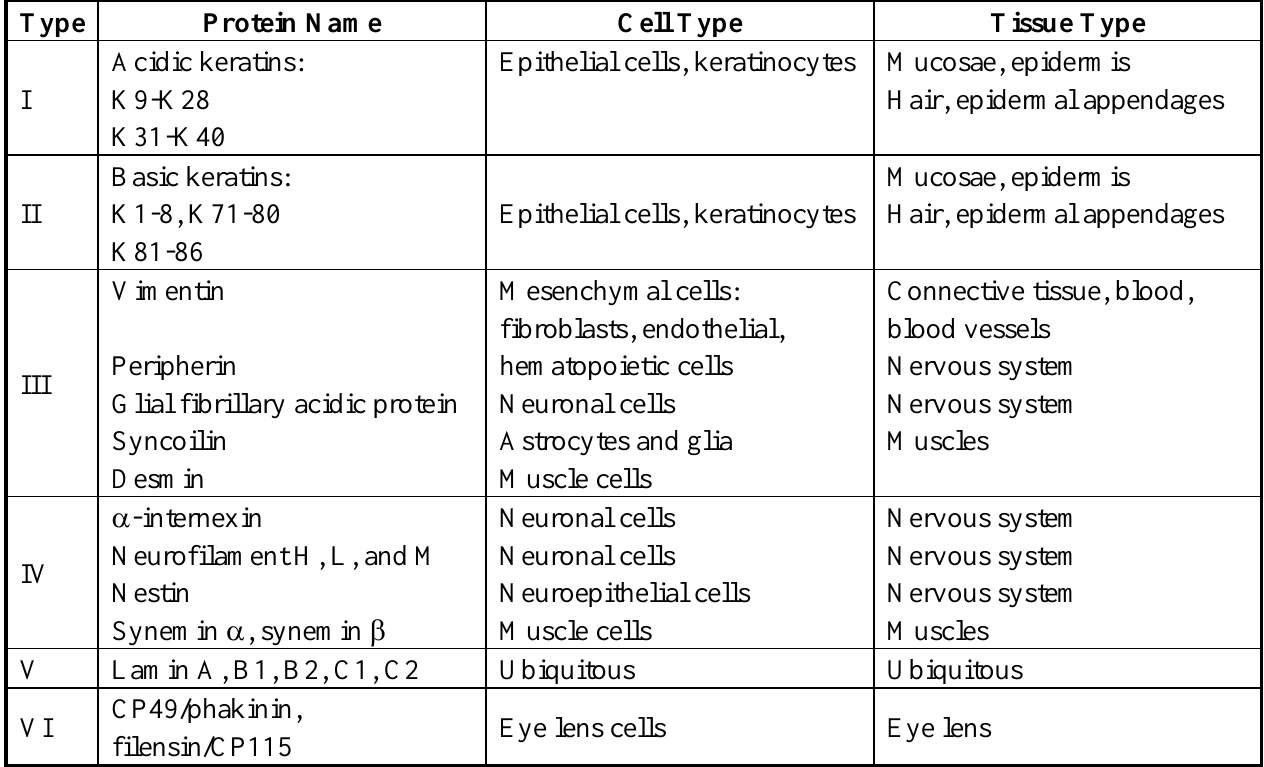
Table 1. Identity, tissue distribution and intracellular localization of intermediate filament (IF) family